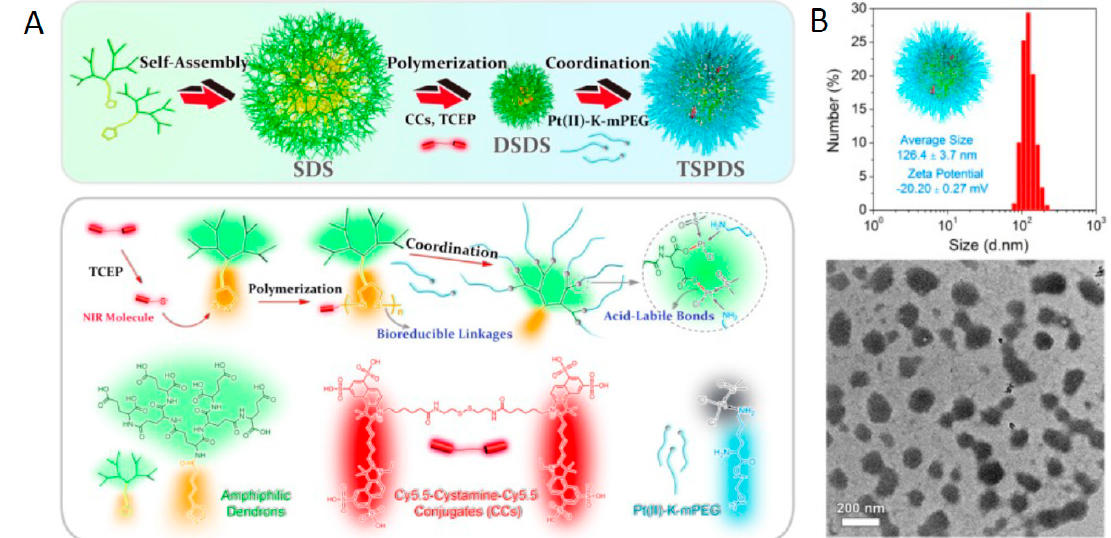
Figure 6. ( A ) Schematic illustrations for molecular and supramolecular engineering of theranostic supramolecular PEGylated dendritic systems. ( B ) Dynamic Light Scattering (DLS) results (in aqueous solutions) and TEM images for Theranostic supramolecular PEGylated dendritic systems (TSPDSs). Reprinted with permission from reference [114].